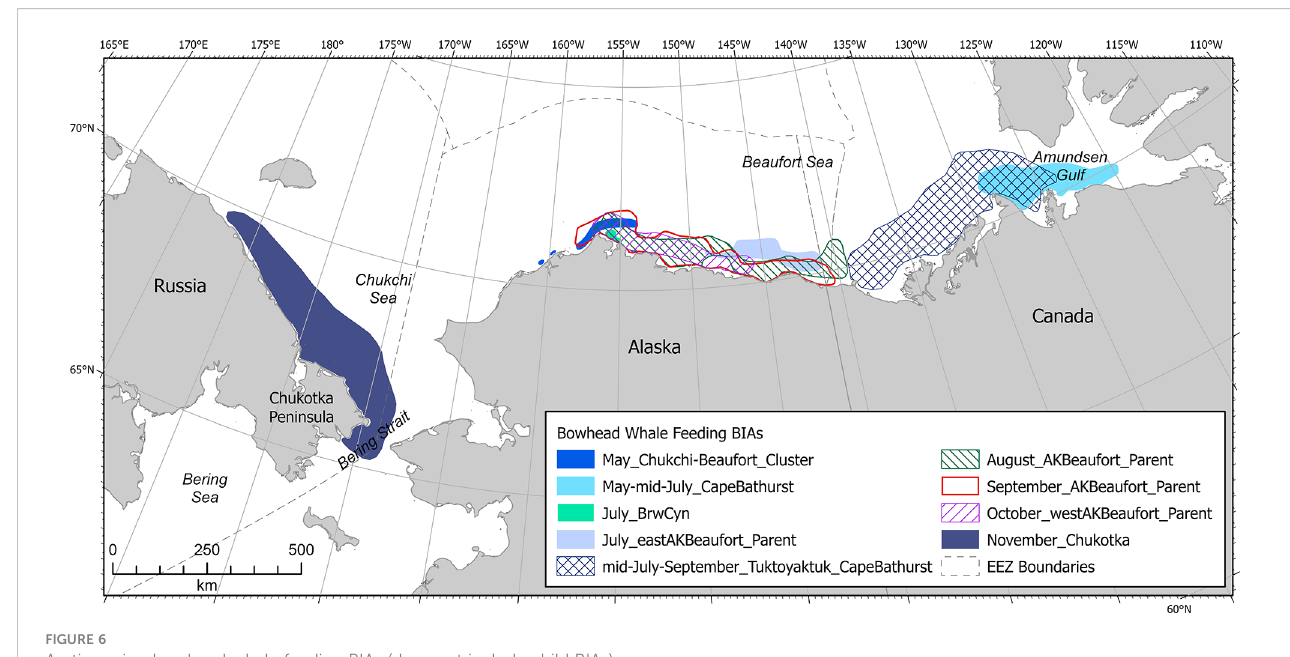
FIGURE 6 Arctic region bowhead whale feeding BIAs (does not include child BIAs).